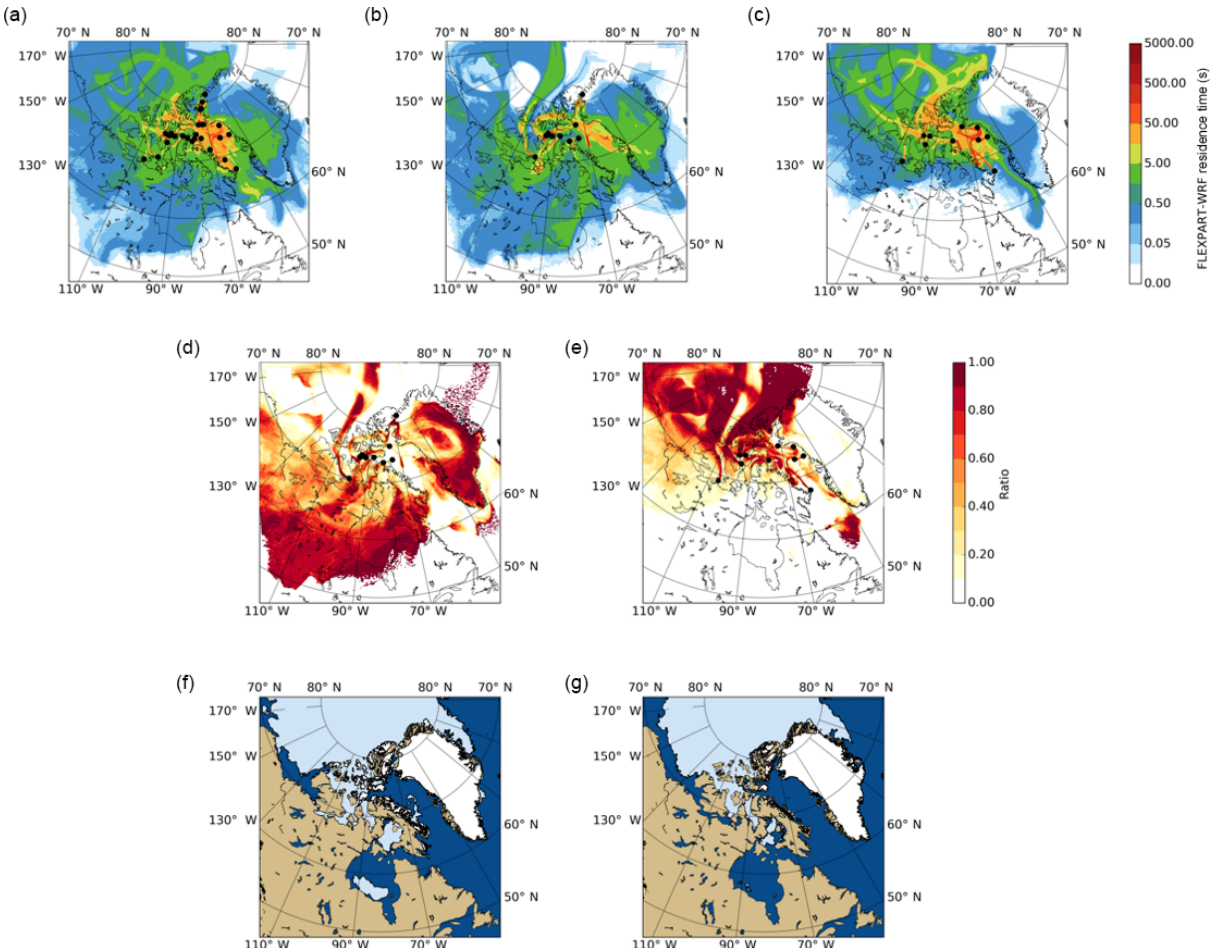
Figure 5. (a–c) Average FLEXPART-WRF footprint potential emission sensitivity (PES) plots for (a) all sampling days, (b) the 36% of samples with the highest [INP( T )] (L − 1 ), and (c) the 36% of samples with the lowest [INP( T )] (L − 1 ). Black circles indicate the ship’s position at the sampling midtime. (d, e) Maps showing the ratios of panel (b) to panel (a) (shown in panel d ) and panel (c) to panel (a) (shown in panel e ). (f, g) Maps showing the surface cover type on (f) the first day of sampling (14 July), and (g) the last day of sampling (12 August). Bare land, open water, sea ice, and snow cover are shown as beige, dark blue, light blue, and white, respectively. Note that for this study, lakes are included in the bare land